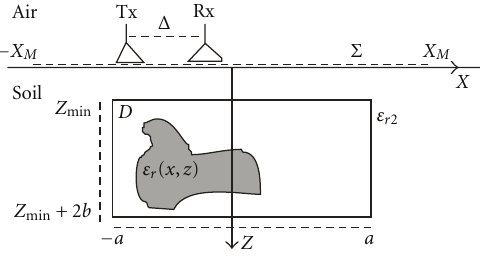
Figure 8: Geometry of 2D inverse scattering